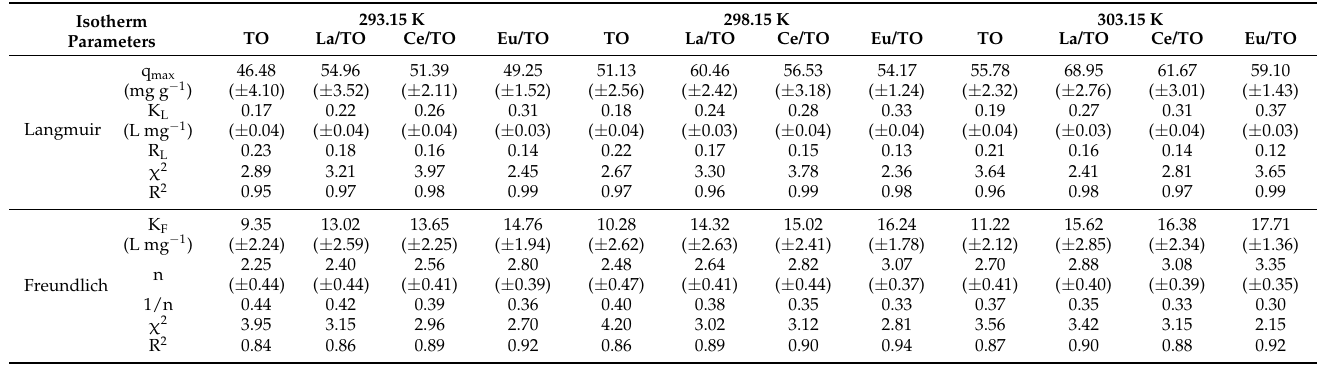
Table 2. Isotherm parameters for cyanide sorption on nanoparticles at different temperatures. 293.15 K 298.15 K Isotherm TO La/TO Ce/TO Eu/TO TO La/TO Ce/TO Eu/TO Parameters